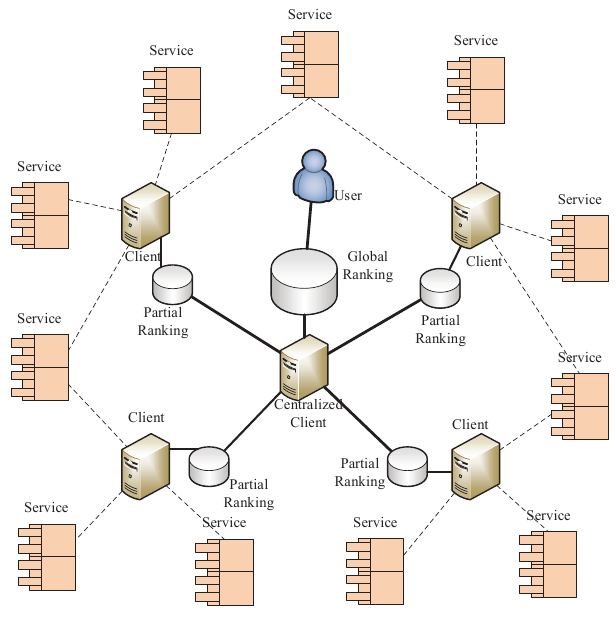
Figure 3. Pairwise comparison